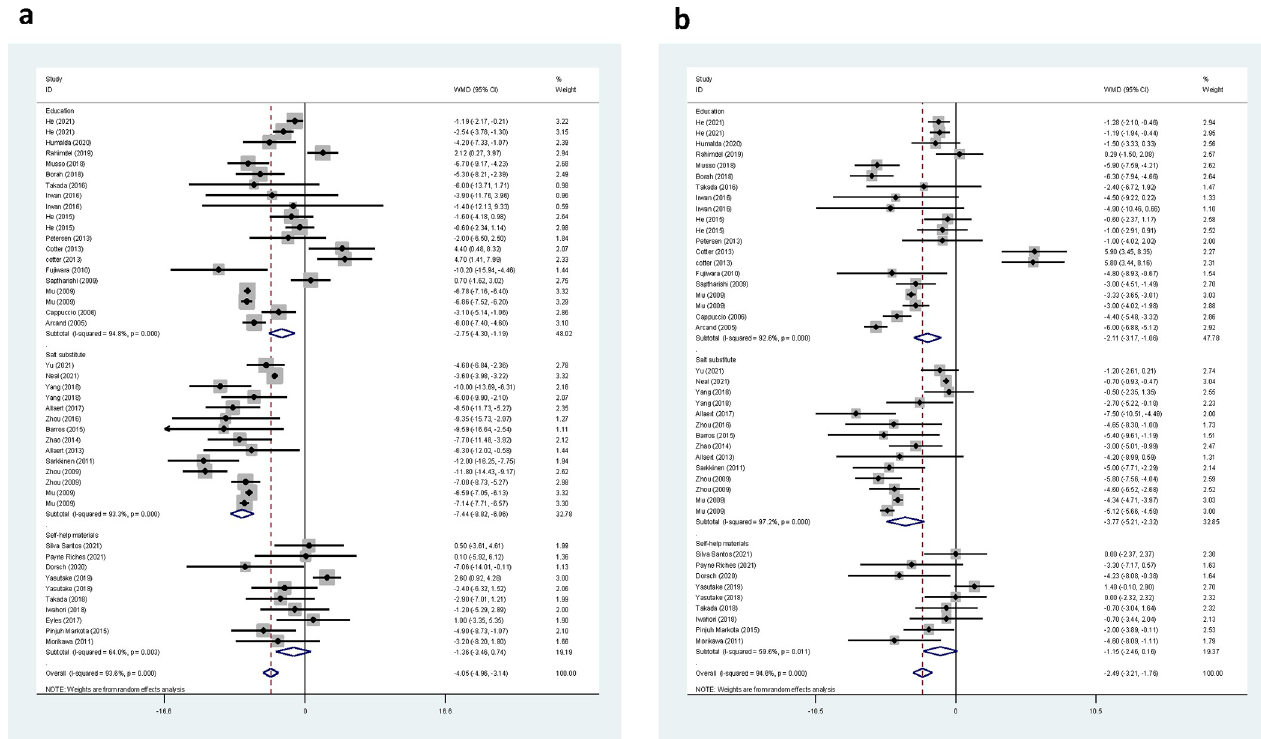
Fig 2. Forest plots of the overall effect of salt reduction intervention on SBP (a) and DBP (b).